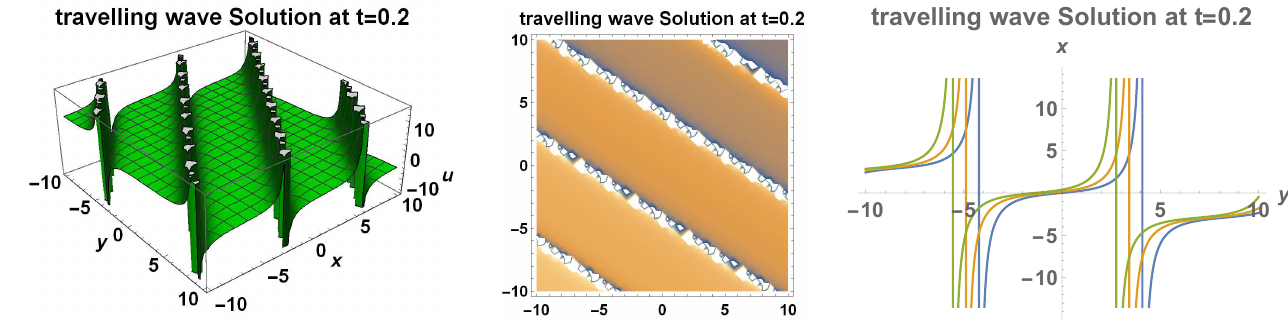
Figure 23. Wave profile depiction of nontrivial unbounded solution (103) at t = 0.7.